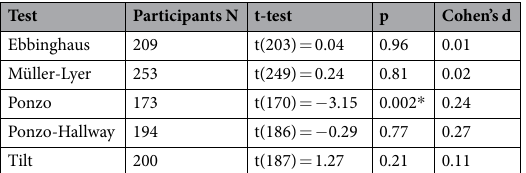
Table 3. Sample C (see also Table 1). Independent t-test results for the five visual illusions. Cohen’s d was calculated using the pooled standard deviation. We found that females were more susceptible to the Ponzo illusion than males.